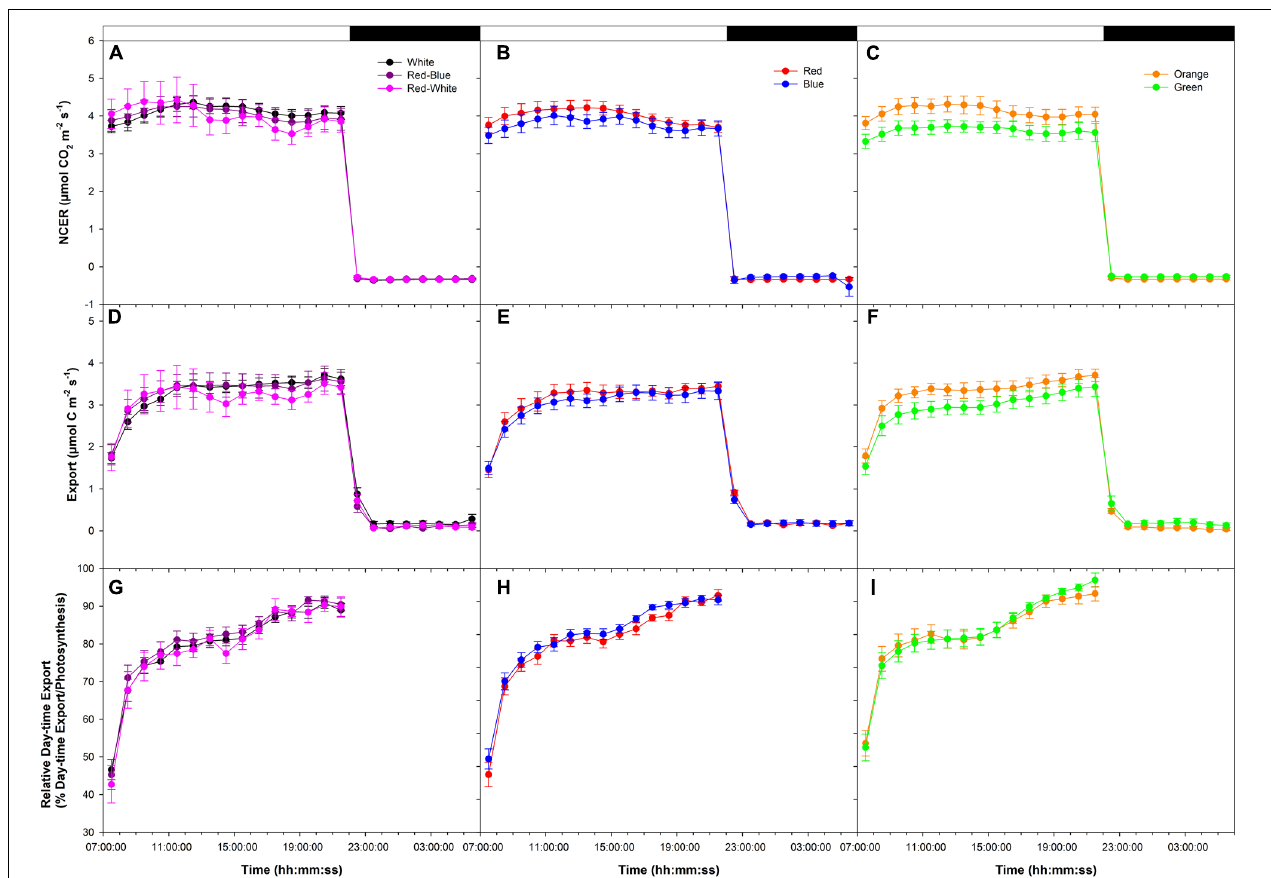
FIGURE 3 | Daily patterns of leaf NCER and export at an initial low photosynthetic rate of ∼ 4 µ mol m − 2 s − 1 as affected by different spectral qualities. The NCER (A–C) , export (D–F) , and relative export (export as a percentage of photosynthesis; G–I ) exposed to mixed LEDs system, RB, W, and RW are shown in A,D,G . The NCER, export, and relative export from R and B are shown in B,E,H while O and G are shown in C,F,I